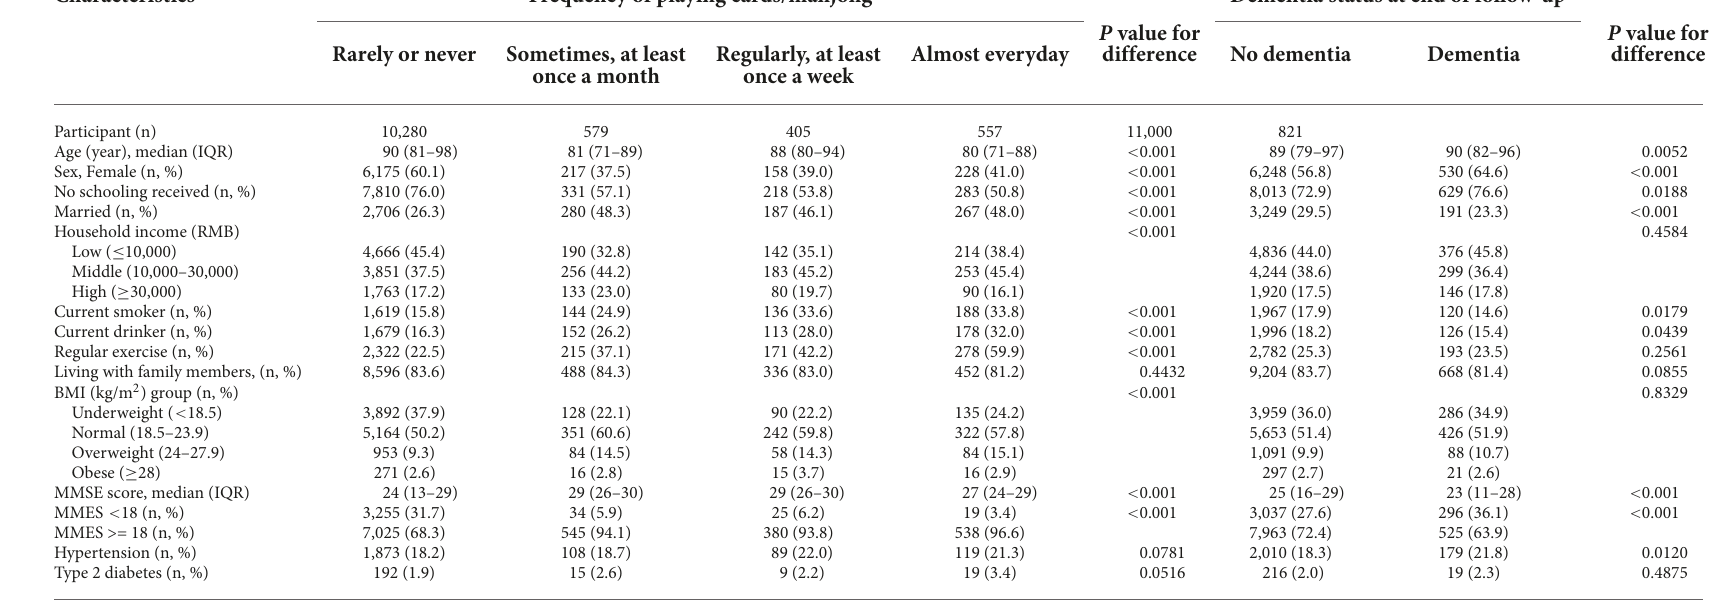
TABLE 1 Characteristics of the study participants according to the frequency of playing cards/mahjong and Dementia status at end of follow-up at baseline. Characteristics Frequency of playing cards/mahjong Dementia status at end of follow-up